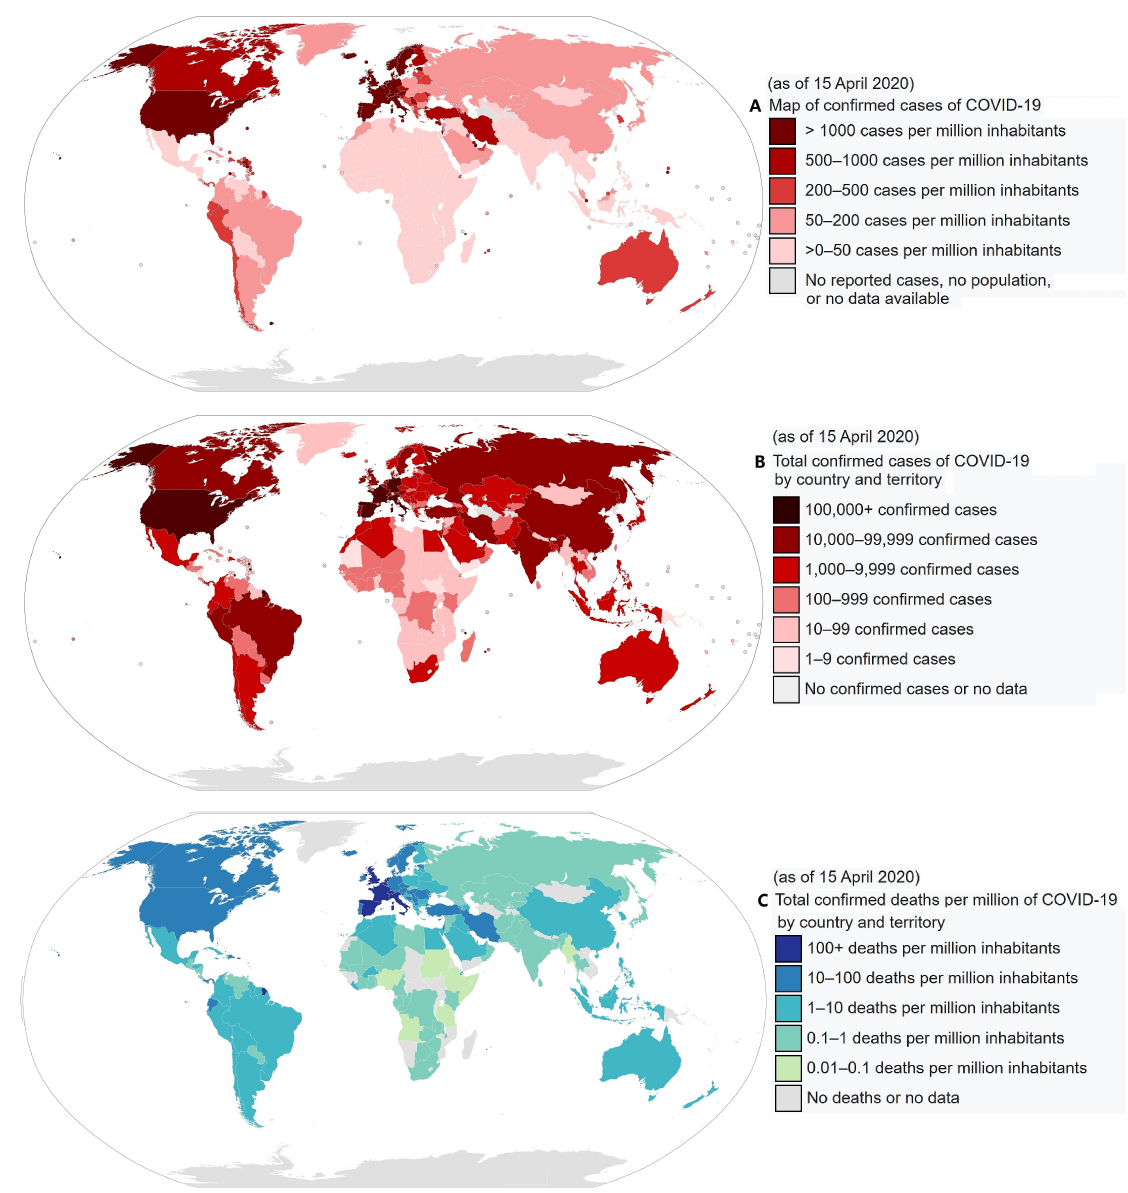
Figure 2. COVID-19 pandemic by country and territory: ( A ) confirmed cases per million inhabitants; ( B ) total confirmed cases by country and territory; ( C ) total confirmed deaths per million of COVID-19 by country and